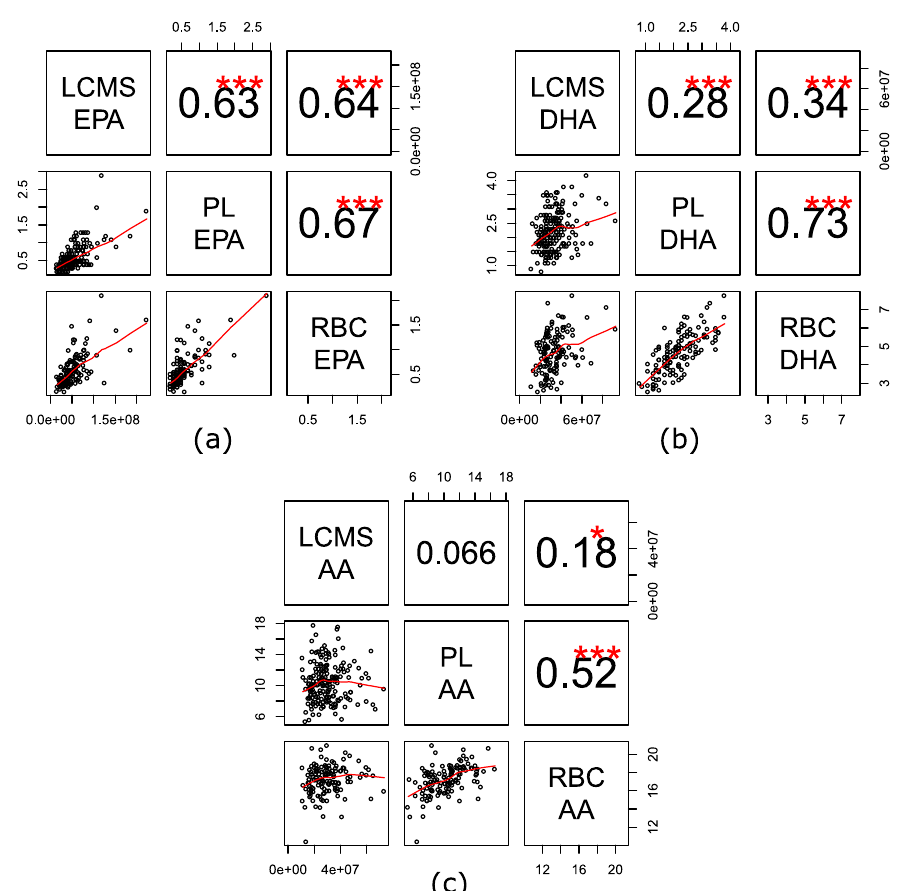
Figure 1. Spearman correlation of baseline levels of fatty acids (FAs). ( a ) Eicosapentaenoic acid (EPA); ( b ) docosahexaenoic acid (DHA); ( c ) arachidonic acid (AA) across three assays. Assays: LCMS—high-throughput liquid chromatography–mass spectrometry of circulating free FAs, oxylipins, and bioactive lipids in plasma; RBC—gas chromatography with flame ionization detection for red blood cells; PL—LCMS2 plasma phospholipids. *** 0 < p -value < 0.001, ** 0.001 ≤ p -value < 0.01, * 0.01 ≤ p -value <